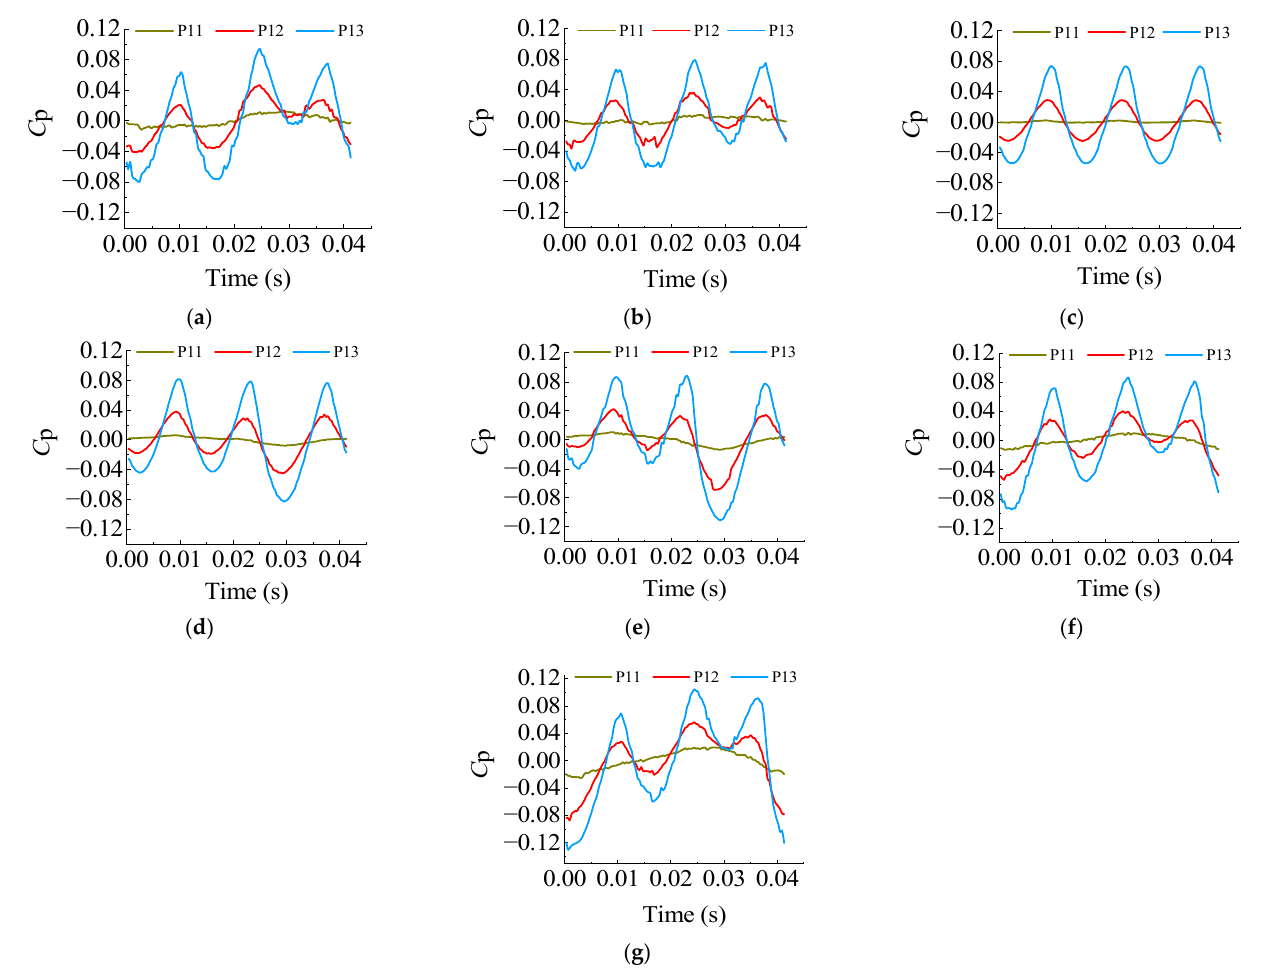
Figure 12. Time ‐ domain diagrams of the pressure fluctuations at the impeller inlet: ( a ) Design Scheme I; ( b ) Design Scheme II; ( c ) Design Scheme III; ( d ) Design Scheme IV; ( e ) Design Scheme V; ( f ) Design Scheme VI; and ( g ) Design Scheme VII. Table 2. Pulsation amplitudes at P1. Table 3. Amplitudes of the dominant frequency at